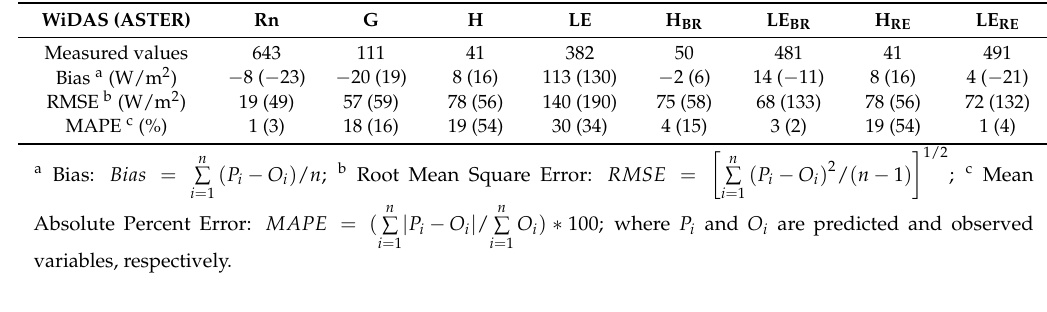
Table 1. Statistical performance of the flux components obtained by applying TSEB to WiDAS and ASTER images. The values in parentheses are the statistical results using the ASTER image. The subscripts BR and RE refer to the Bowen ratio and the residual methods enforcing energy balance closure,